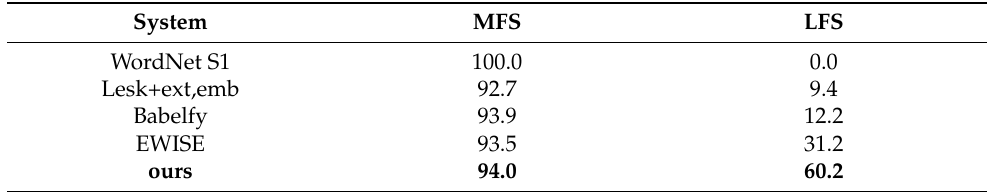
Table 4. F1-score (%) on words labeled with most frequent sense (MFS) and words labeled with less frequent senses (LFS) of the ALL set.